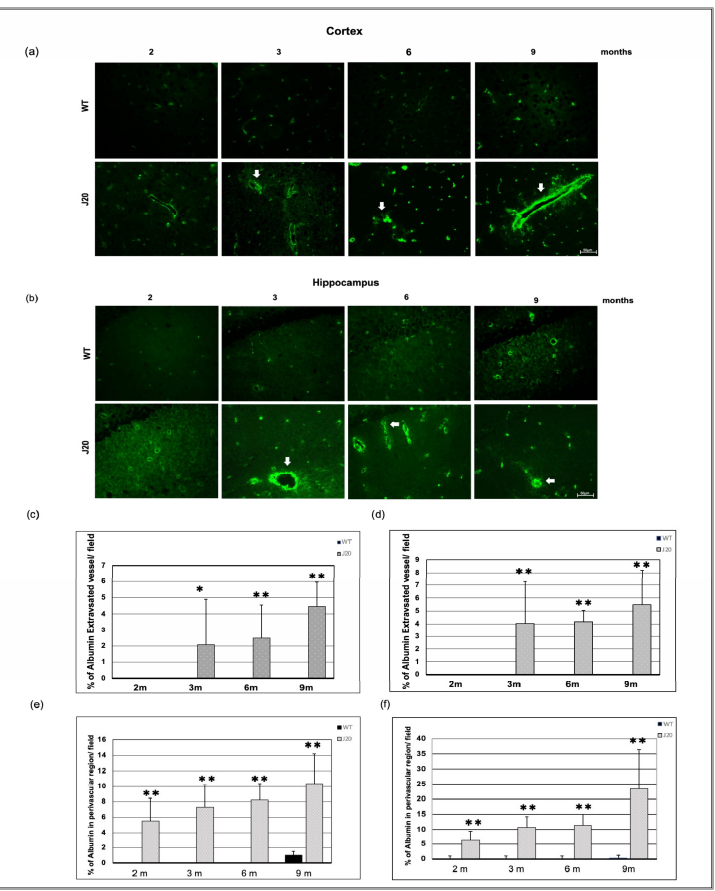
Figure 6. Time-dependent immunoreactivity of albumin in J20 mice brains. Albumin immunostaining in the cortex ( a ) and hippocampus ( b ) of the brains of WT and J20 mice at 2, 3, 6, and 9 months. Albumin leaked into the parenchyma (extravasation) (indicated by white arrows). The number of % of extravasated vessels per field in the cortex ( c ) and the hippocampal ( d ) area was counted at 400 magnifications in a blinded manner. Furthermore, the number of % of albumin in the perivascular region of vessels per field in the cortex ( e ) and the hippocampus ( f ) (Figure S2). Numerical data are presented here as average ± SD, and statistical significance is denoted as * p < 0.05, ** p < 0.01 vs. age-matched WT. M indicates month. Scale bar = 50 µ